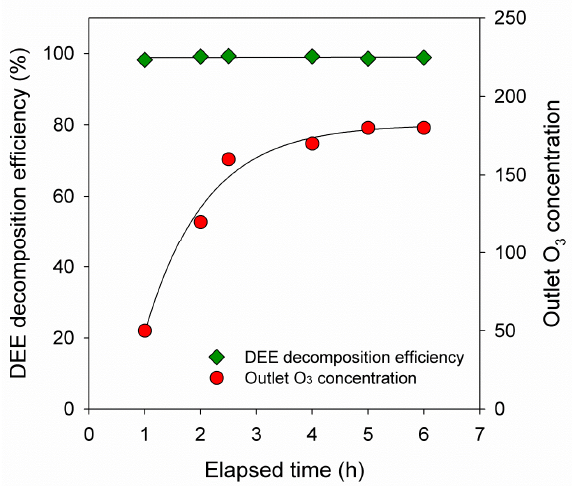
Figure 10. DEE decomposition efficiency and outlet ozone concentration of hybrid Mn+(Mn-Fe) reactor at a SIE of 382 J L − 1